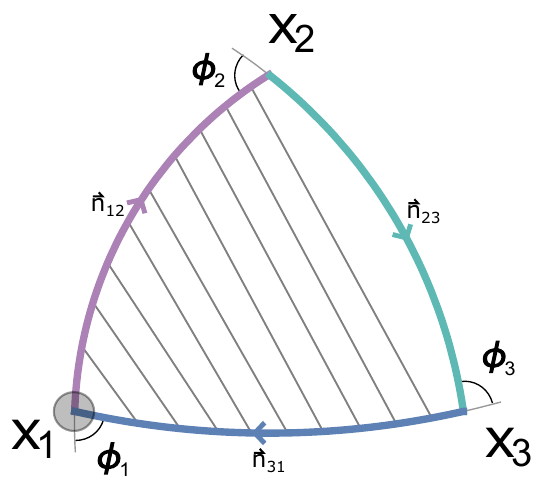
Figure 8 . The HLL correlator corresponds to the situation when the couplings ^ g 2 and ^ g 3 are zero. In this case there is only one type of propagators to